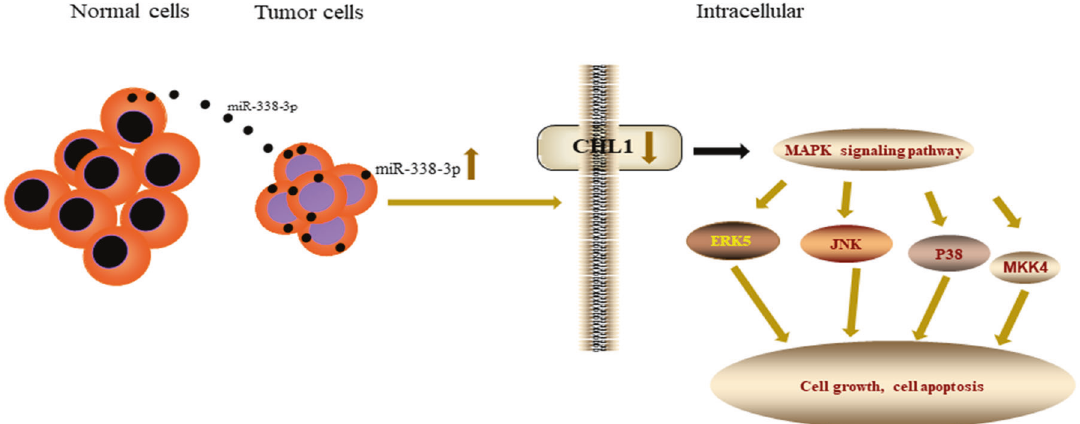
Fig. 8 miR-338-3p was transferred by exosomes to NSCLC cells to inhibit CHL1 expression by inactivating MAPK signaling pathway to regulate the tumor cells metastasis.